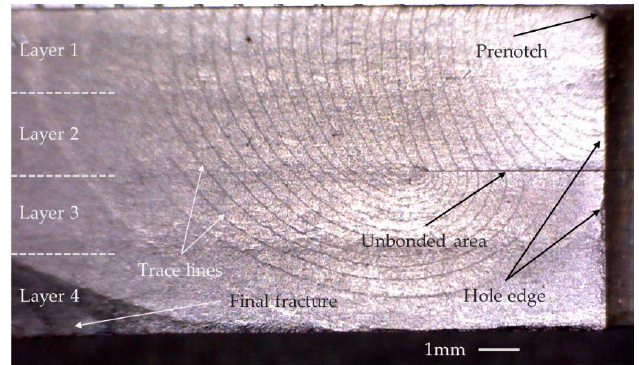
Figure 4. The fracture Fig.4 The fracture surface